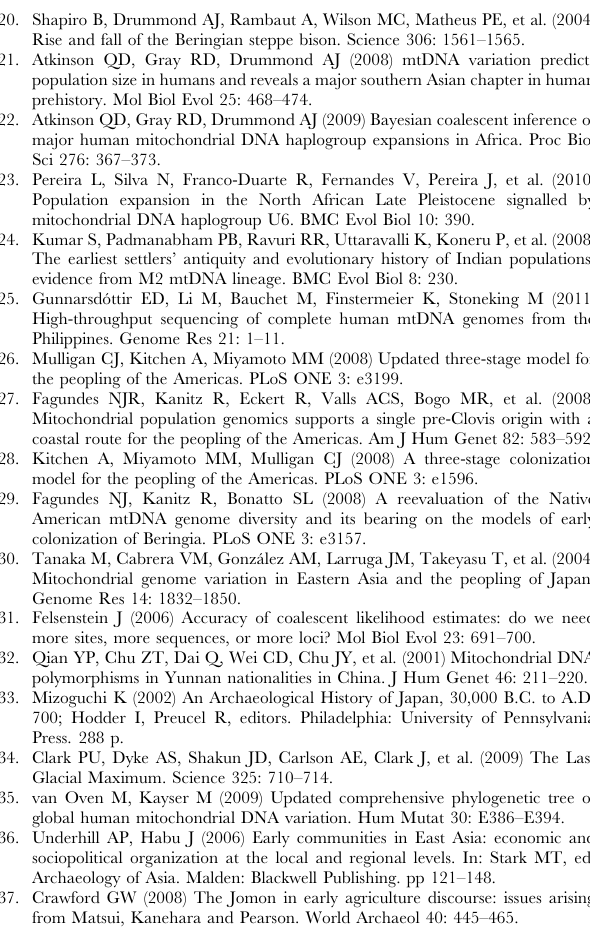
Figure S1 BSP of female effective population size (N ef ) through time for total Japanese mtDNA lineages. This